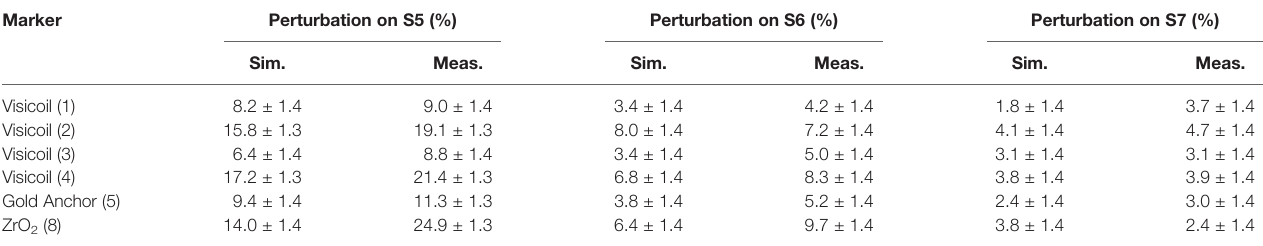
TABLE 8 | Comparison of the fl uence perturbation values at several positions (sensor 5, sensor 6, and sensor 7) between the FLUKA simulations (Sim.) and the CMOS measurements (Meas.) for the different fi ducial markers for the 142MeV proton beam. Marker Perturbation on S5 (%) Perturbation on S6 (%) Perturbation on S7 (%) Sim.